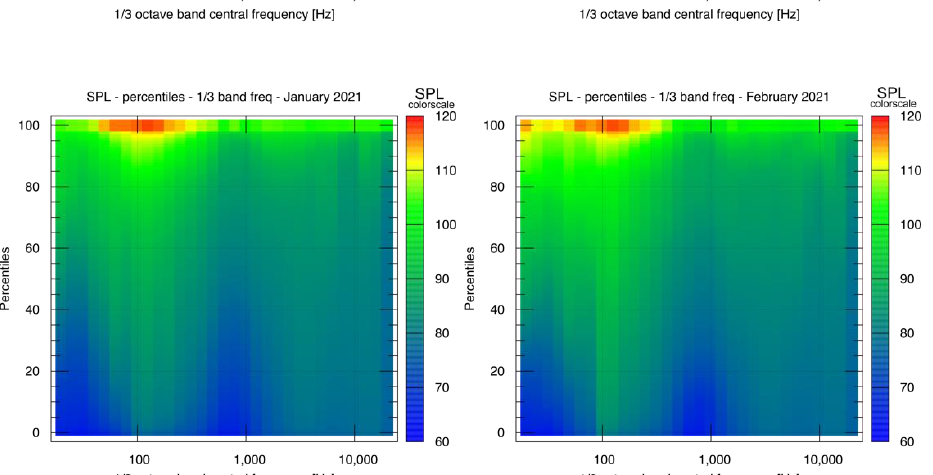
Figure 13. Percentiles versus the one-third octave band central frequency plot of SPL levels in the range between 60 dB and 120 dB.